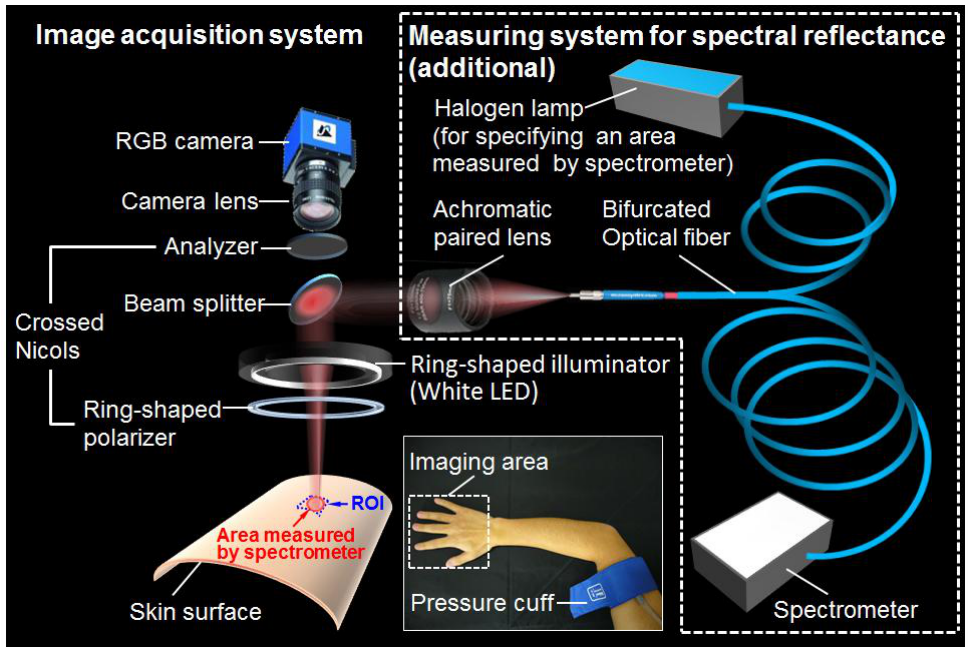
Figure 1. Experimental configuration for the image acquisitions and the spectral reflectance